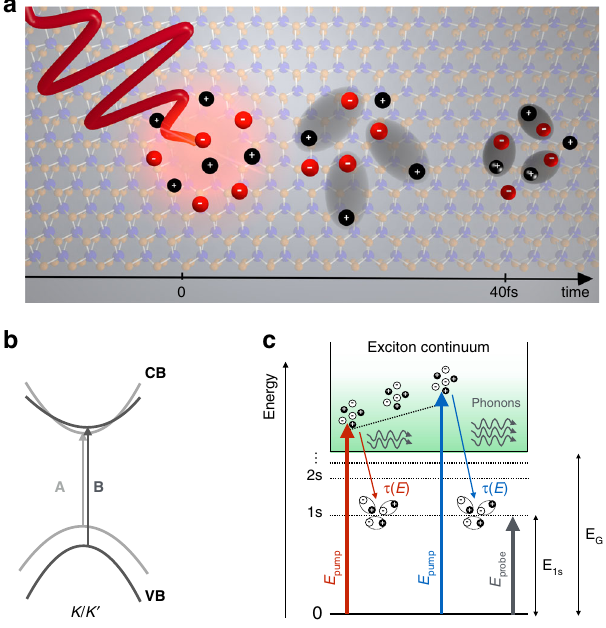
Fig. 1 Exciton formation process in 1L-MoS 2 . a Cartoon of the exciton formation process after photo-injection of free electron-hole pairs. b Schematic illustration of the single particle band structure of 1L-MoS 2 at the K/K' points. The two arrows represent A/B excitonic transitions, split due to the strong spin-orbit interaction at the K/K' points of the Brillouin zone. c Sketch of the pump-probe experiment. A few-optical-cycle laser pulse injects free electron/hole pairs at increasing energies above the exciton continuum (E G ). These quasiparticles lose their initial kinetic energy and scatter down via a cascade process mediated by phonons to lower- lying discrete excitonic states until they reach the 1s excitonic state. The timescale τ (E) of this relaxation process is determined by measuring the absorption change of a probe beam, tuned on resonance with the 1s state, due to the Pauli blocking